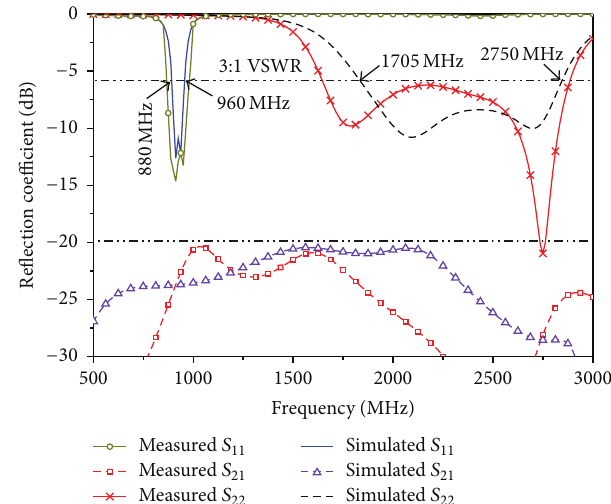
Figure 4: Simulated and measured reflection coefficient of the proposed dual-feed PIFA.